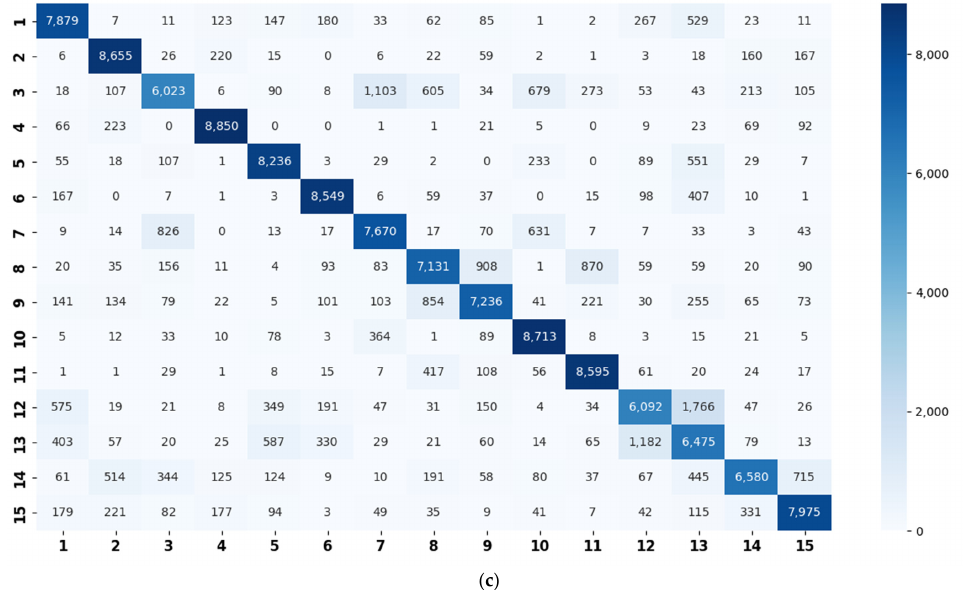
Figure 7. Confusion matrices on the TUT Acoustic Scenes 2017 dataset generated by the basic models ( a ) using STFT spectrograms; ( b ) using CQT spectrograms; and ( c ) using log-Mel spectrograms. The abscissa represents the predicted label, and the ordinate indicates the true label. Note: Beach (1), bus (2), café/restaurant (3), car (4), city center (5), forest path (6), grocery store (7), home (8), library (9), metro station (10), office (11), park (12), residential area (13), train (14), and tram (15). Table 2. Clustering details of the constructed super-class for the TUT Acoustic Scenes 2017 dataset. The classes marked by the same shape with the same color are grouped into the same super-class. Clustering Scheme